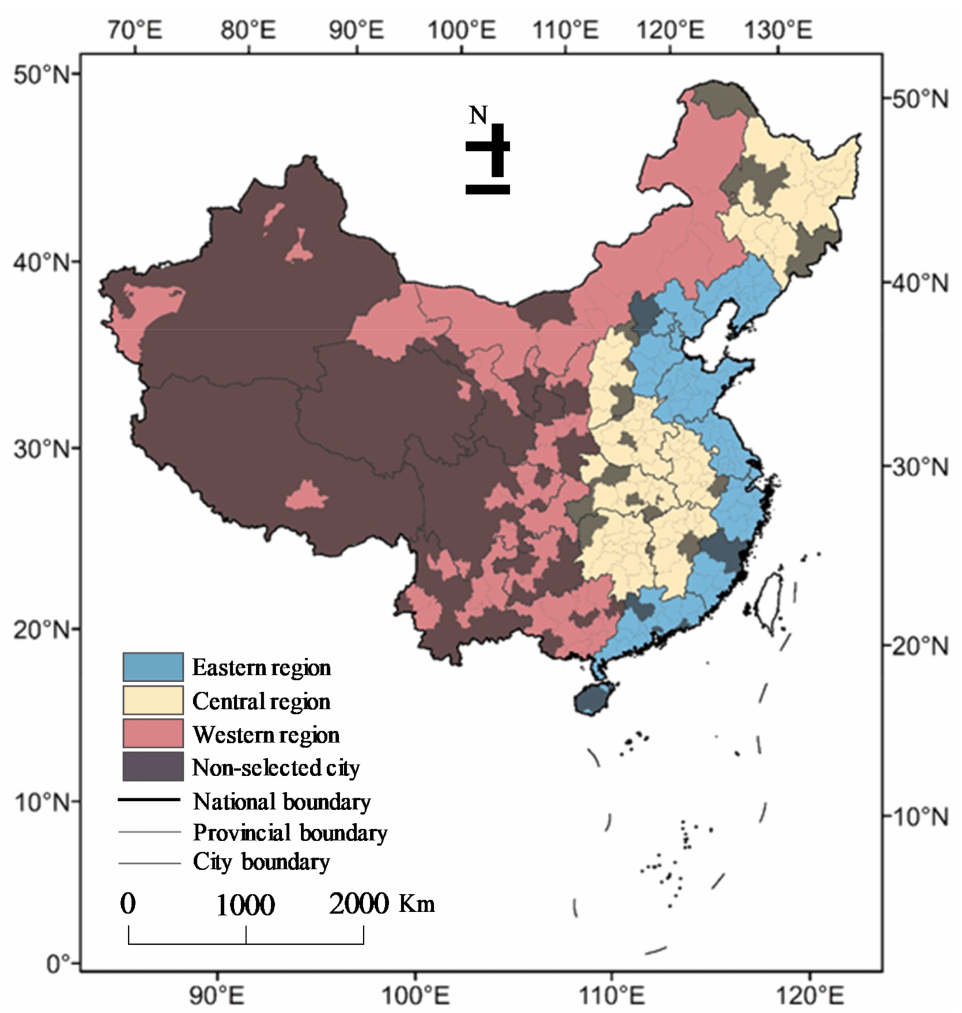
Figure 1. The distribution of the studied provinces and cities in